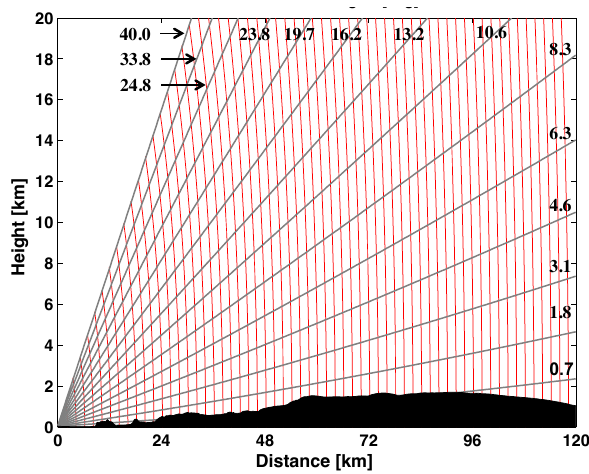
Fig. 1. Radar scan strategy in terms of range–height plot adopted for the mobile X-band radar located at the Iceland site. The antenna elevation angles [deg] are shown close to each theoretical radar ray paths (grey lines). For sake of clarity the radar range gate sizes are shown every 2km by red lines instead of the original resolution of 0.25km. The terrain elevation profile along the direction of 21deg clockwise from the north is also displayed in black. The radar is positioned at the origin of the axes, and the Grímsvötn caldera is at approximately 70km away form the